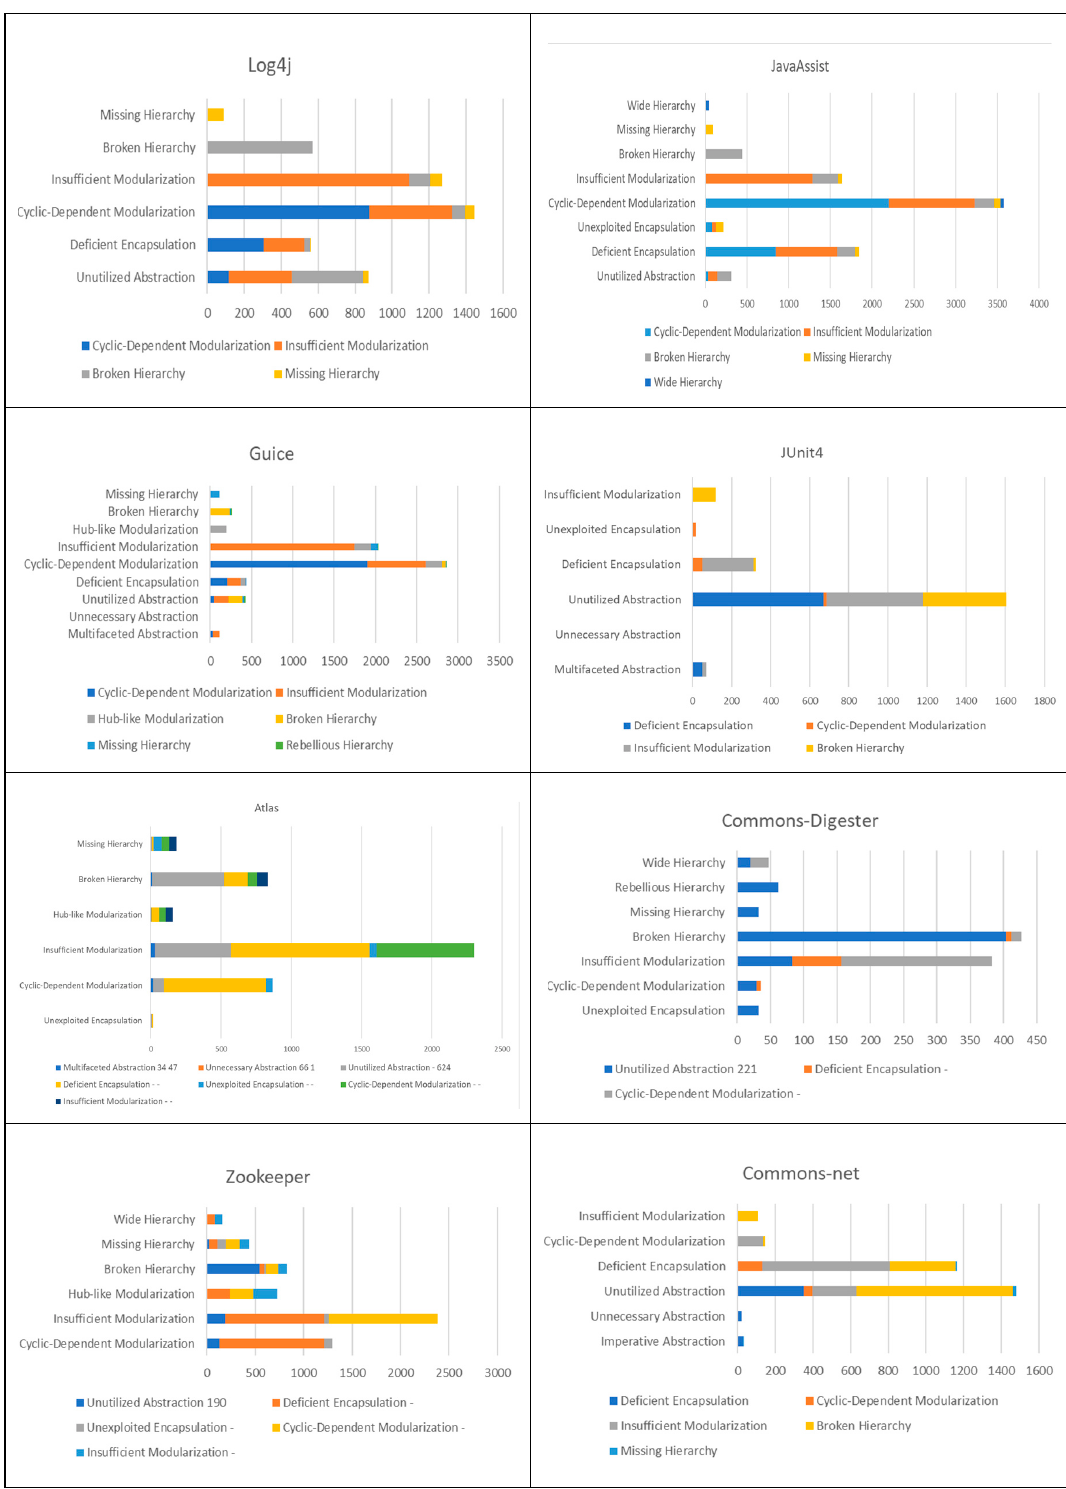
Figure 5. Number of co-changing smelly files.